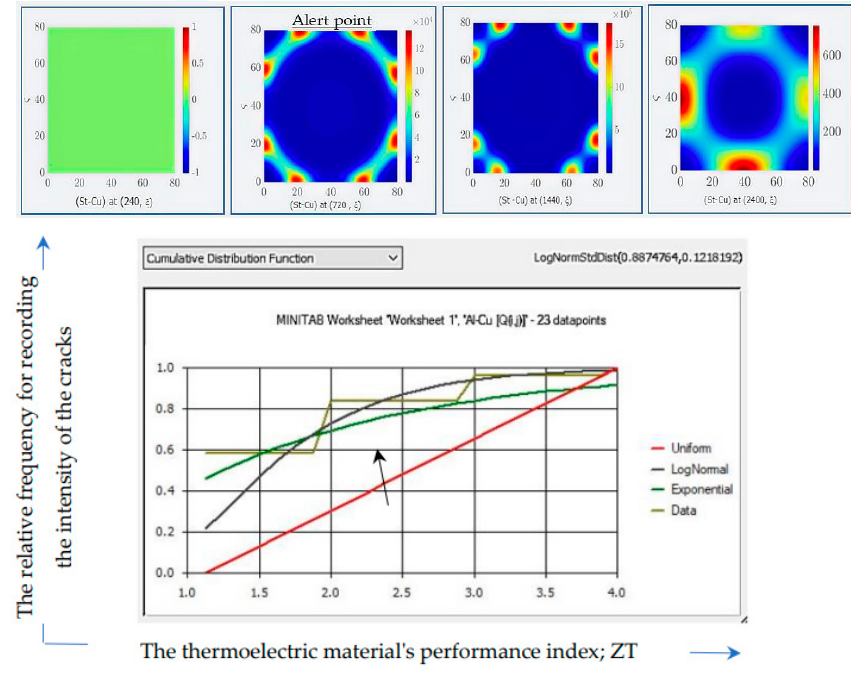
1,2,3,…,𝑛 (mm× 10 (cid:2879)(cid:2869) ) The conductor’s failure begins in the middle and growth [between (1, 4.1)]. Figure 5. The change in the (Al-Fe) gasket alloy resistance working conditions for thermal transfer. ( a ) The behavior of the cracks’ growth through 23 weeks for the Fe-Al alloy is uniform. The cracks and their ramification behavior for the strengthening (Fe-Al) alloy for the gasket and TEG legs to save the thermal conductors via 𝑃 (cid:3036) − and 𝑄 (cid:3017) -like uniform distri-